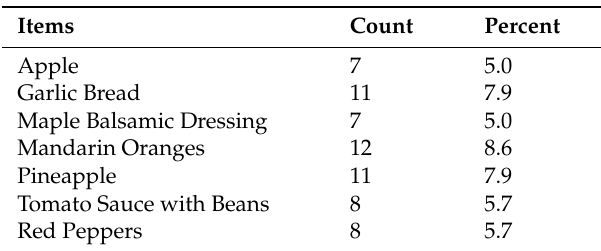
Table 3. Counts of most common exclusions for all meals reported by parents ( n = 40) using ASA24-Canada in relation to true (observed) intakes.